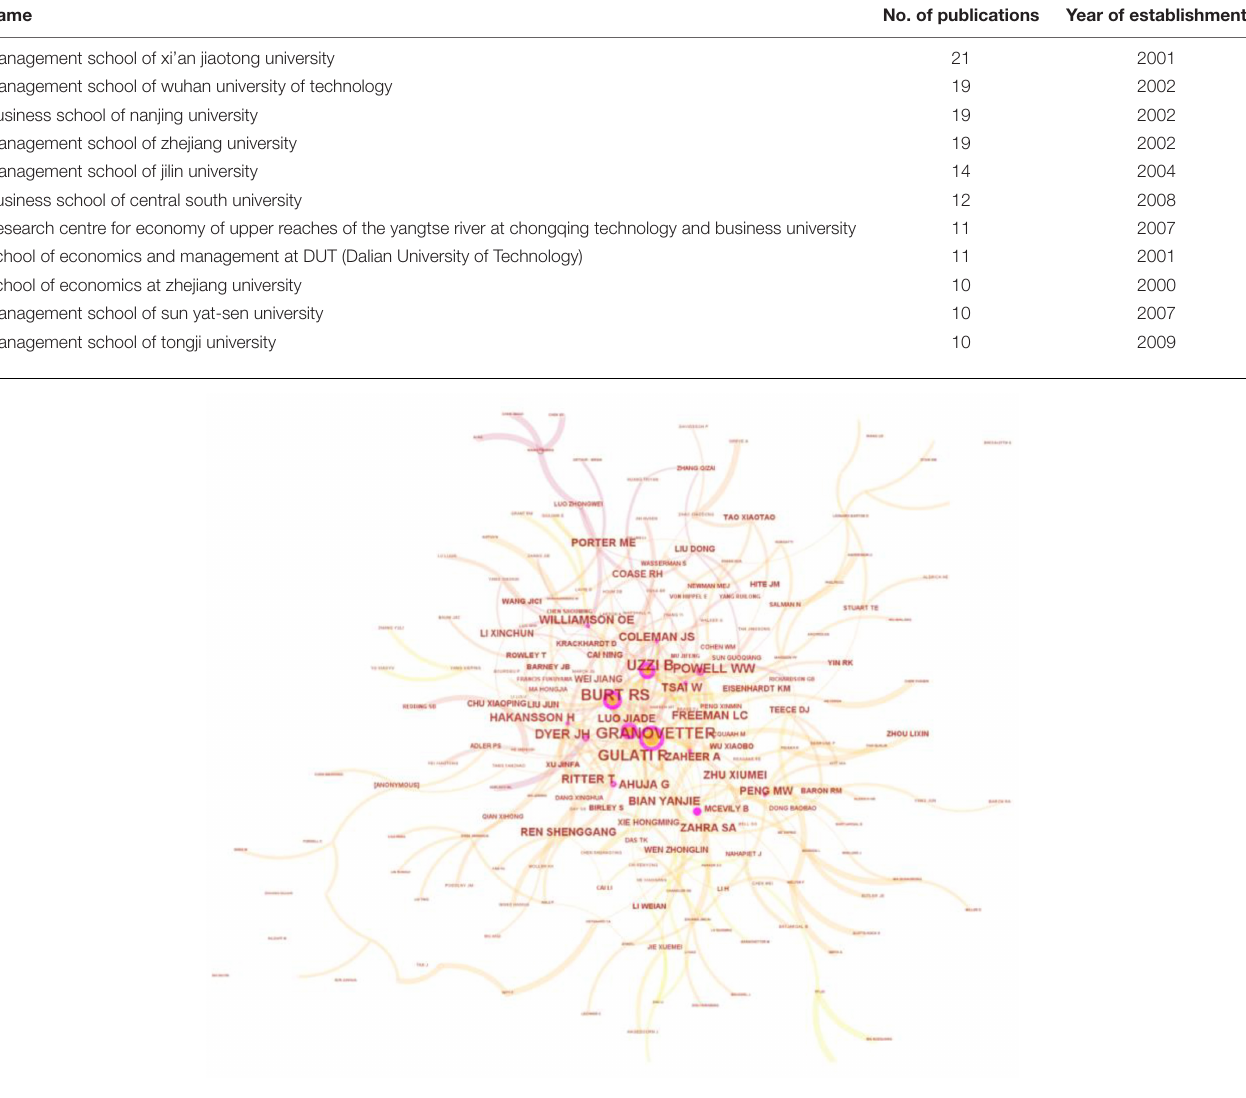
FIGURE 3 | Authors with high frequency of